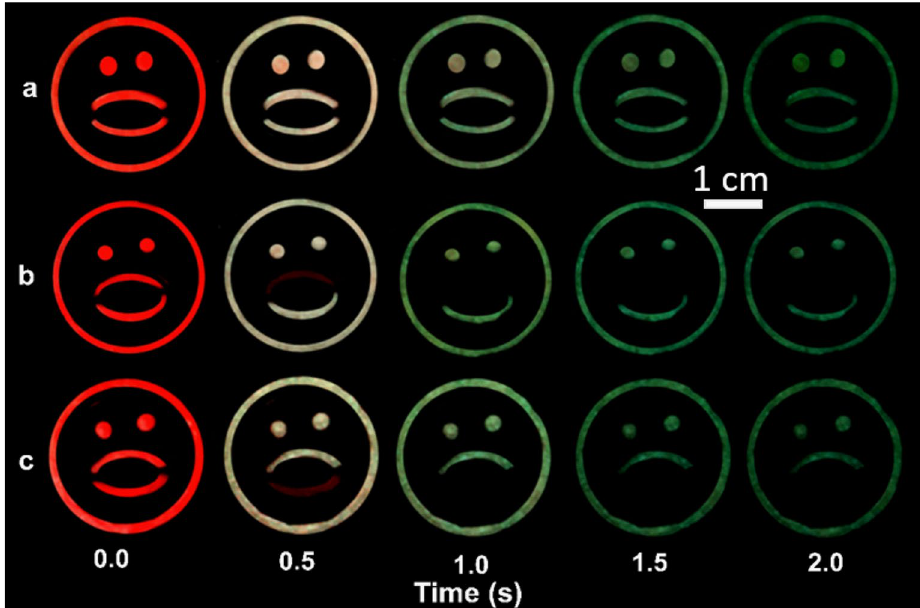
Figure 6. Persistent luminescent emoji images utilizing both color tunability and persistent emission to transform emoji from an initial wow image after smartphone excitation for 10 s. (a) The wow emoji color transforms to a green wow emoji. (b) The initial red wow emoji transforms to a green smiley face emoji after 1 s. (c) The initial red wow emoji transforms to a green sad face emoji after 1 s. The external diameter of the emoji is 3.0